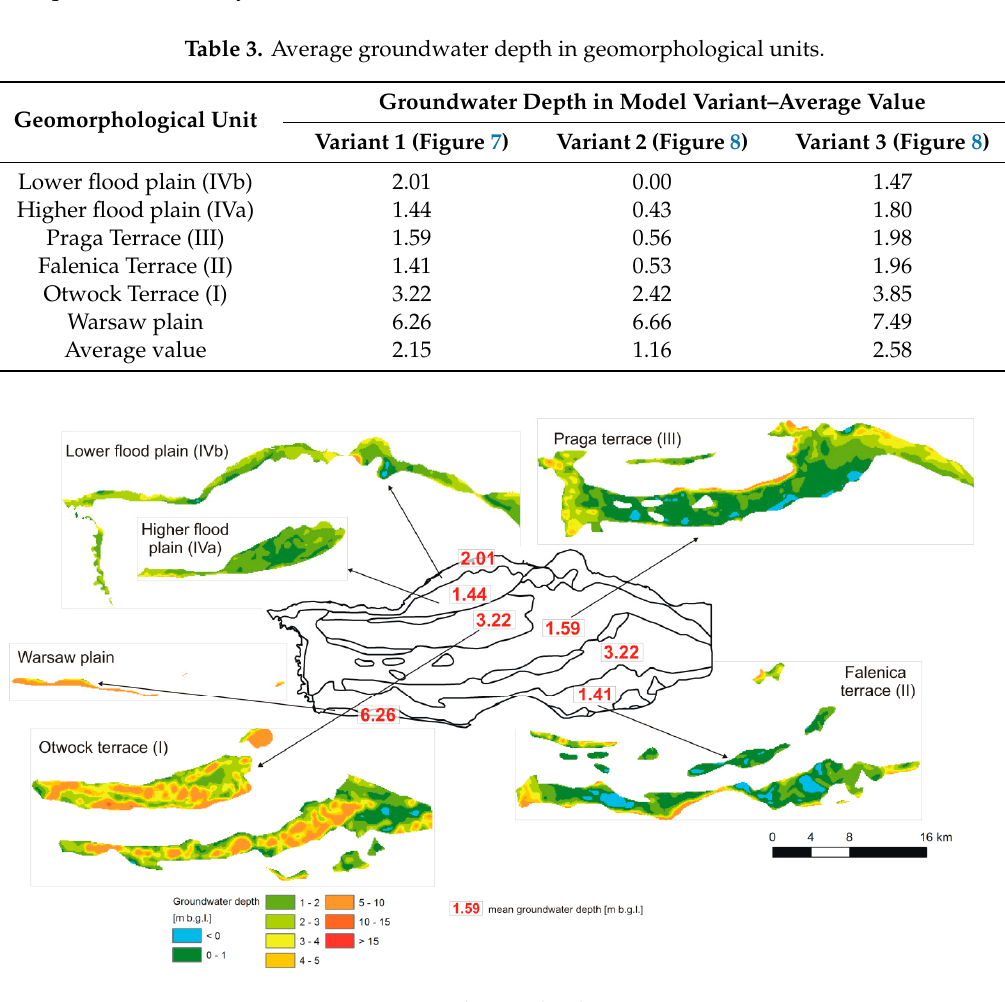
Figure 7. Groundwater depth in variant 1.